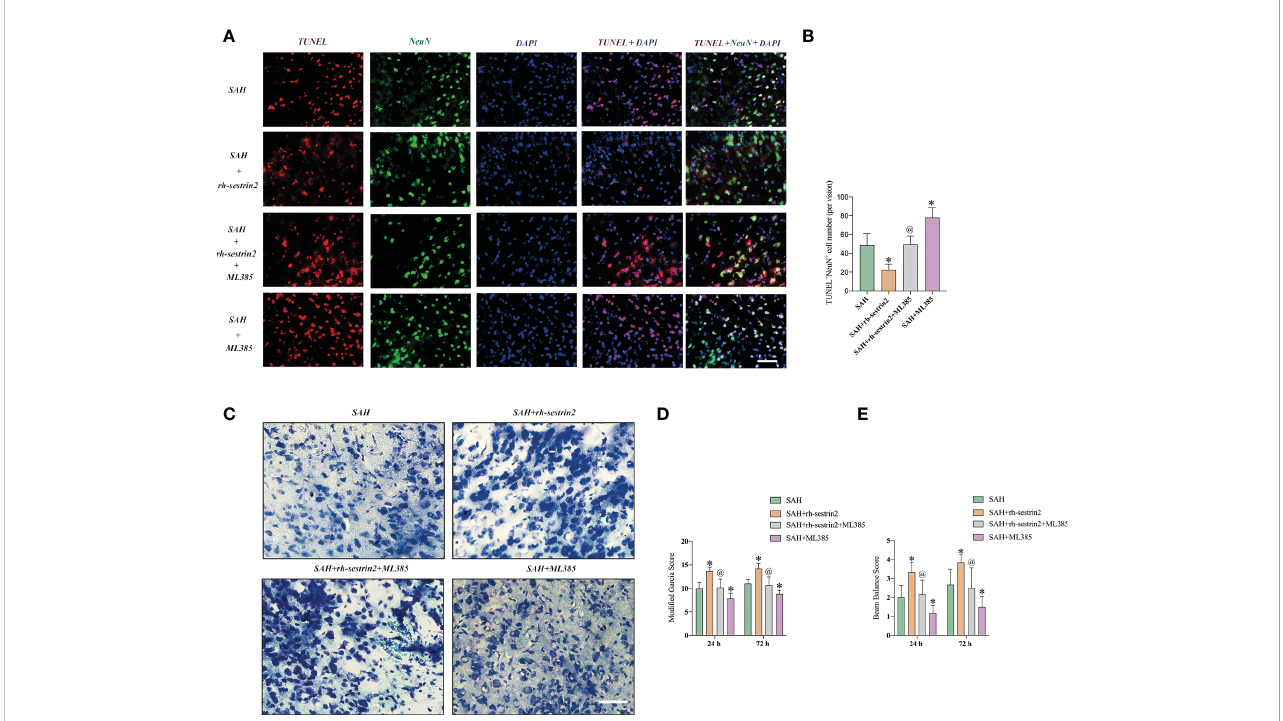
FIGURE 7 ML385 aggravated neuronal apoptosis and exacerbated neurological deterioration after SAH. (A) Representative images and (B) quanti fi cations of TUNEL staining in different groups (n = 6 per group). (C) Representative images of Nissl staining in all groups. Quanti fi cations of (D) modi fi ed Garcia score and (E) beam balance score (n = 6 per group). * P < 0.05 versus SAH group. @ P < 0.05 versus SAH + rh- sestrin2 group. Data indicated as mean ± SD. Scale bars = 50 m